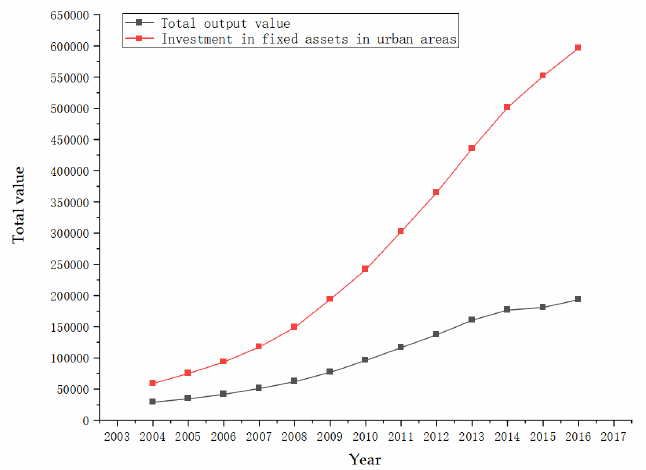
Figure 6. Total output value of construction and investment in fixed assets in urban areas in China.